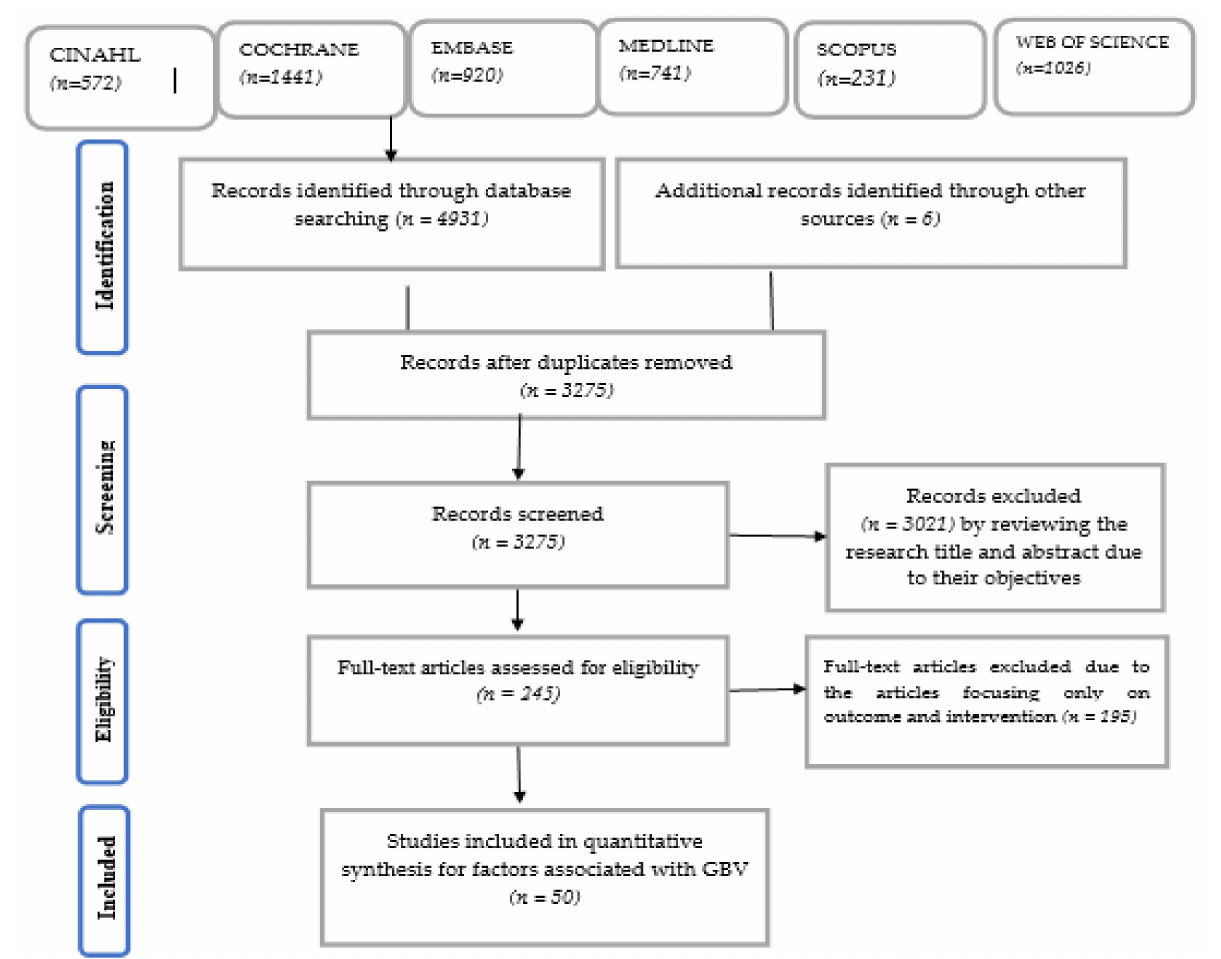
Figure 1. PRISMA flow chart that describes selection process of GBV articles that met inclusion